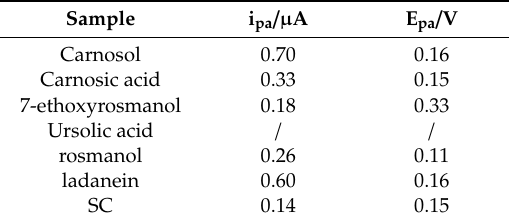
Table 4. Anodic peak properties of S. chamelaeagnea constituents.